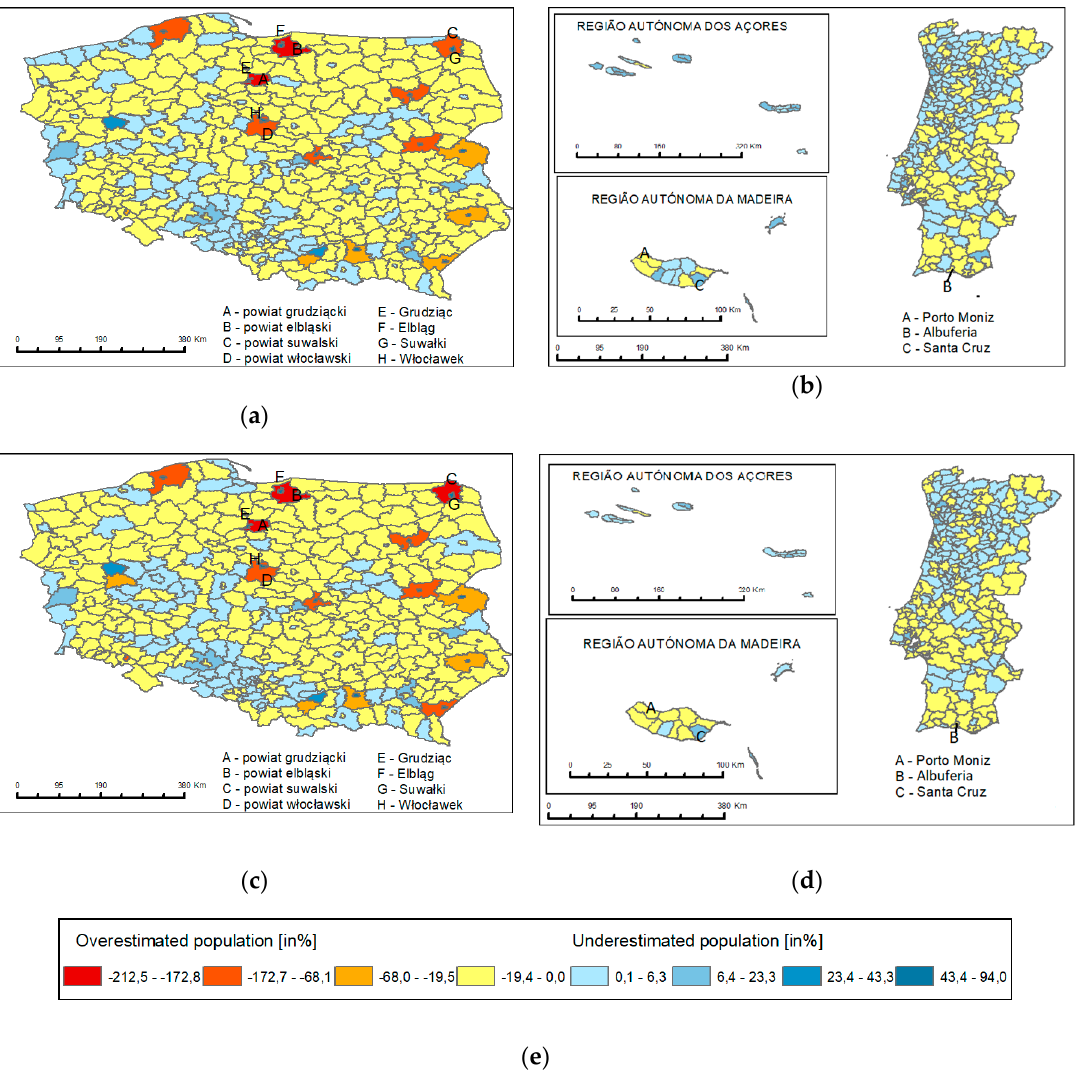
Figure 10. LAU 1 (NUTS 4): MAPE. ( a ) GHS-POP 250 m, Poland; ( b ) GHS-POP 250 m, Portugal; ( c ) GHS-POP 1 km, Poland; ( d ) GHS-POP 1 km, Portugal; ( e ) legend.